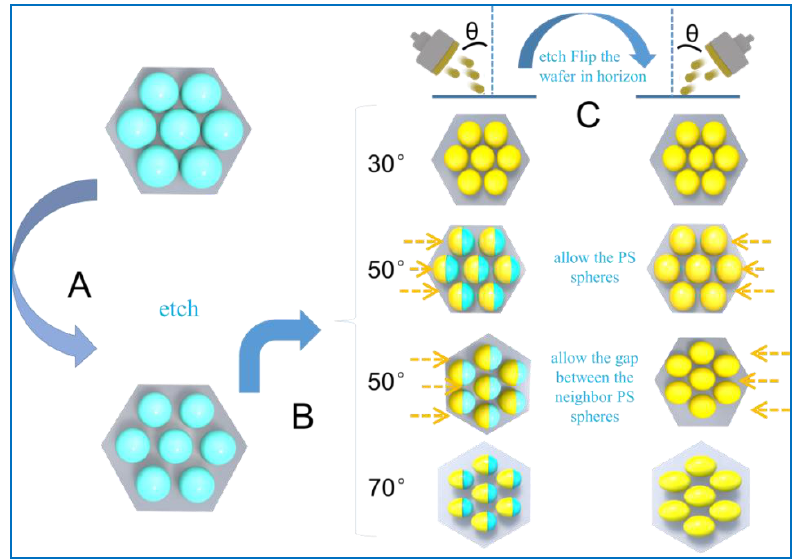
Figure 1. Schematic diagram for the preparation procedure of different shaped nanocaps array ( A ) monolayers on a Si wafer by a self-assembly method. ( B ) PS spheres separated by etching. ( C ) Au nanocaps with different shapes on the PS sphere arrays by depositing Au twice with different rotation